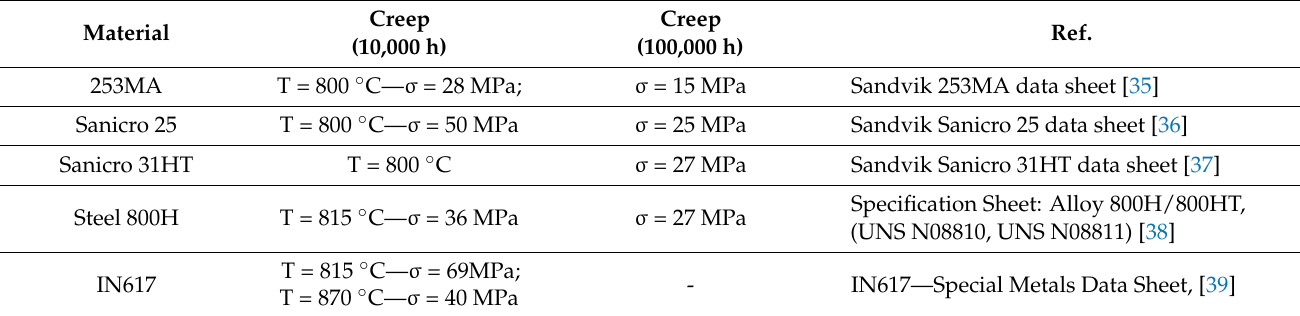
Table 3. Creep property comparison for some structural steels, ( σ : creep-stress at temperature T and at given time).